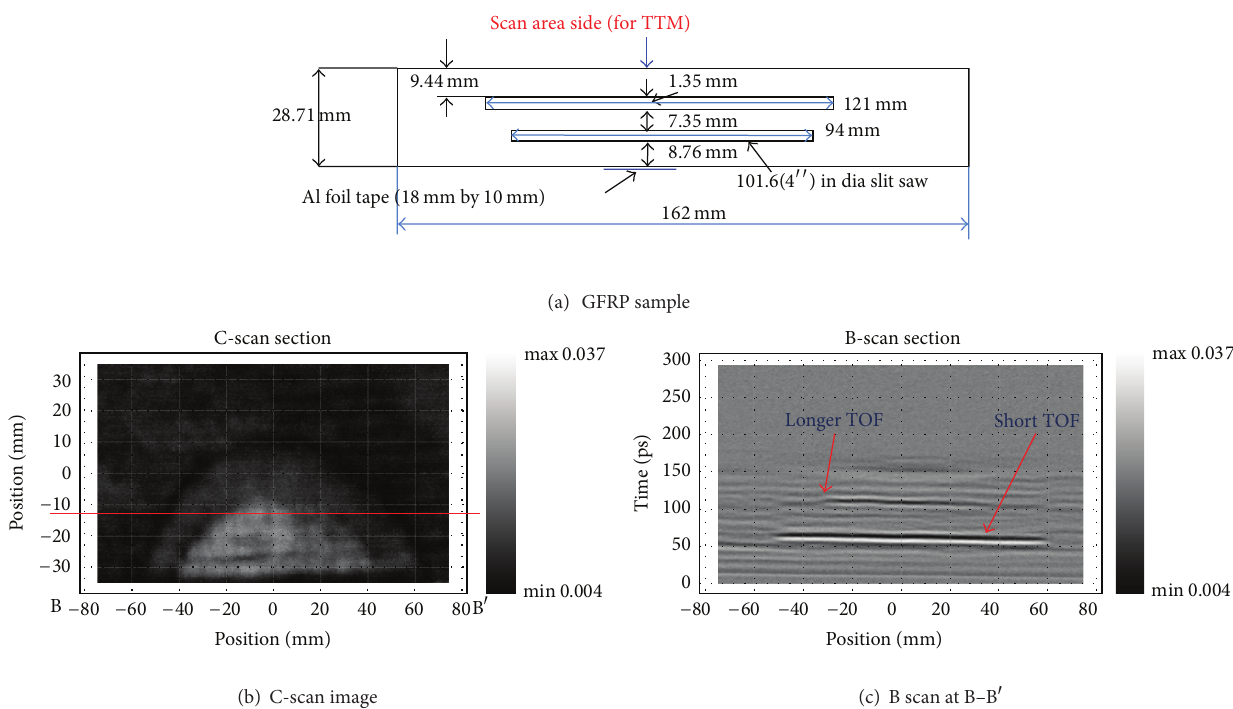
Figure 7: Terahertz TDS through-transmission scan image of double saw slots in a glass composite solid laminate. The results demonstrated that terahertz waves do not suffer from “shadow effect.”